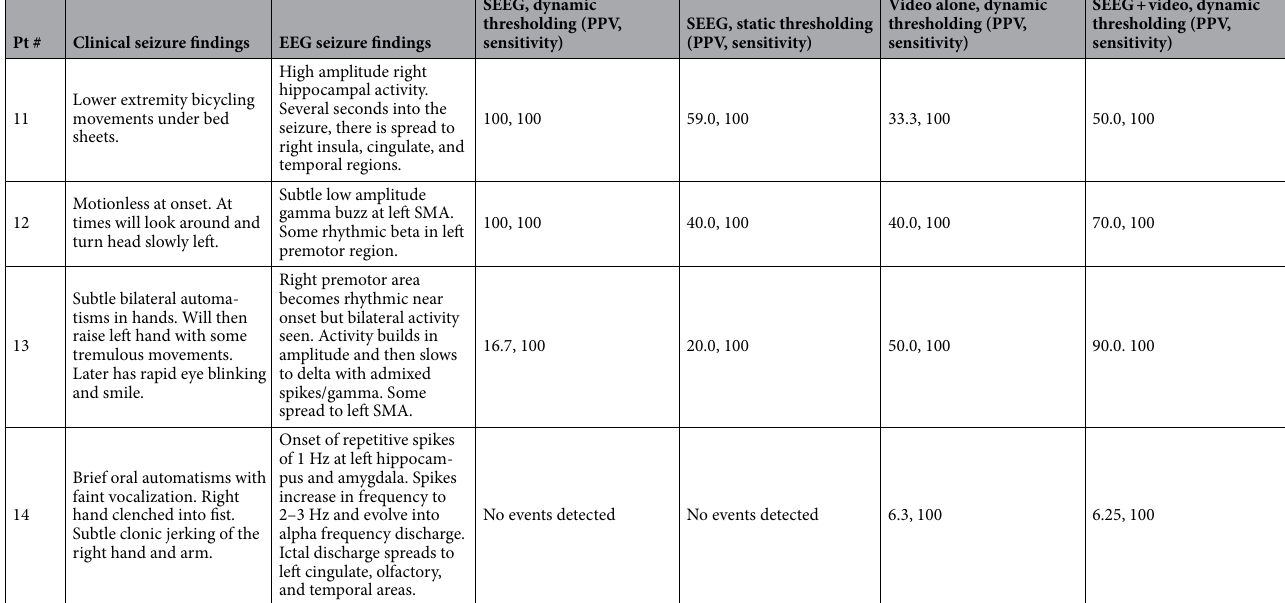
Table 3. Patient-specific clinical and electrophysiologic seizure manifestations, as well as model performance on individual patient recordings. EEG electroencephalographic, Pt patient,